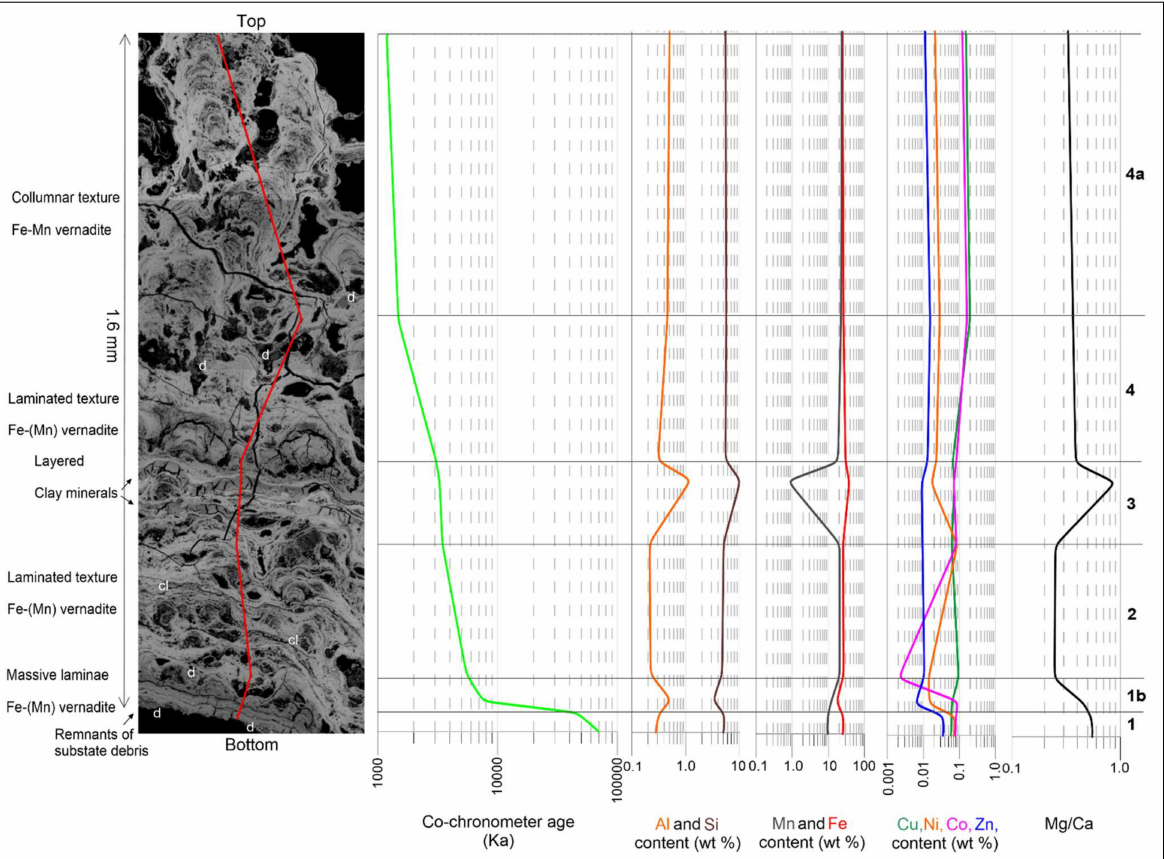
Figure 10. Representative EPMA profile of sample SIO0000D2 (red line) dominated by vernadite. On the photo cross-section visible textural changes, from massive layer of metal rich Fe-(Mn) vernadite in the crust bottom part (1 and 1b), by laminated Fe-(Mn) vernadite (2) and intercalations of clay minerals (3), ending on laminated (4) and columnar vernadite (4a): d—debris, cl—clay minerals. As shown on the geochemical profiles, a slight Zn content increase occurs in the bottom part of crust